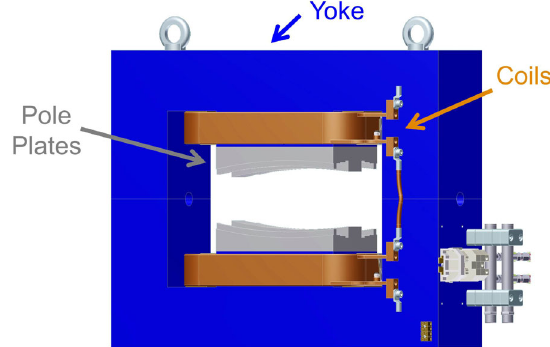
FIG. 4. Chopper dipole with transversely and longitudinally optimized pole contour. The beam direction is perpendicular to the dipole front plane